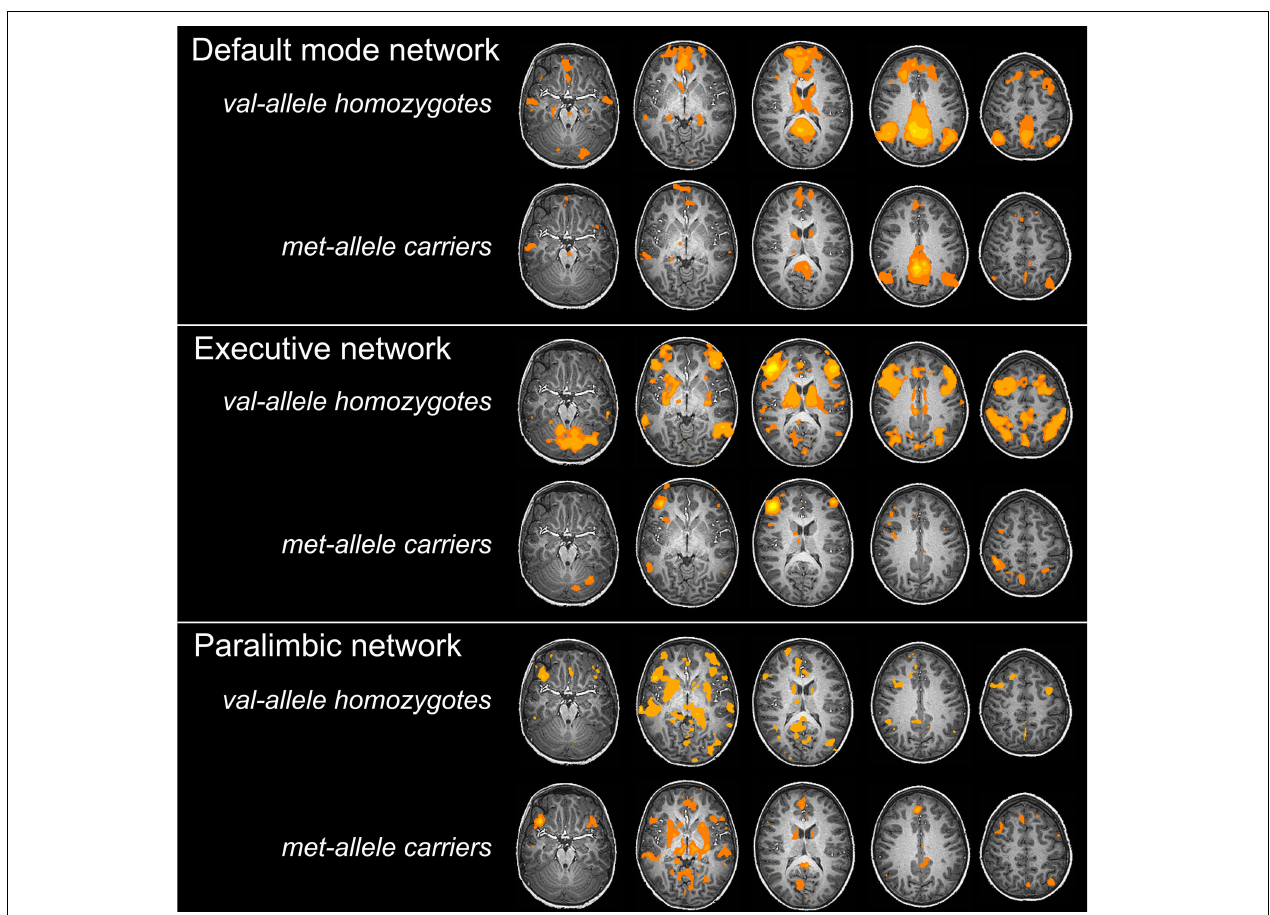
FIGURE 2 | One-sample t -tests within each genetic group depicting group effects for three major resting-state networks at p < 0.0001.